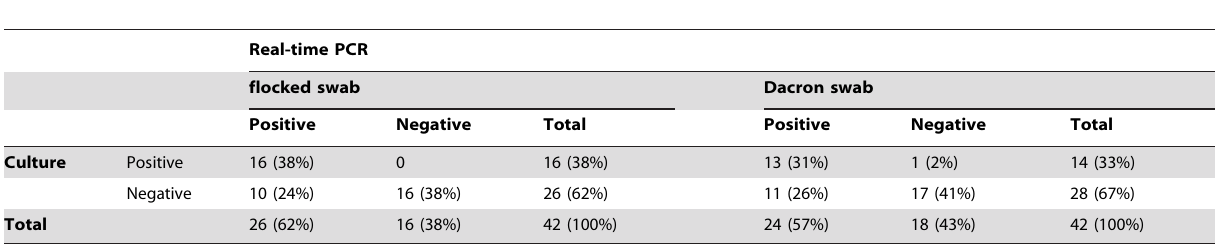
Table 2. Comparison of Streptococcus pneumoniae detection by culture and real-time PCR from healthy